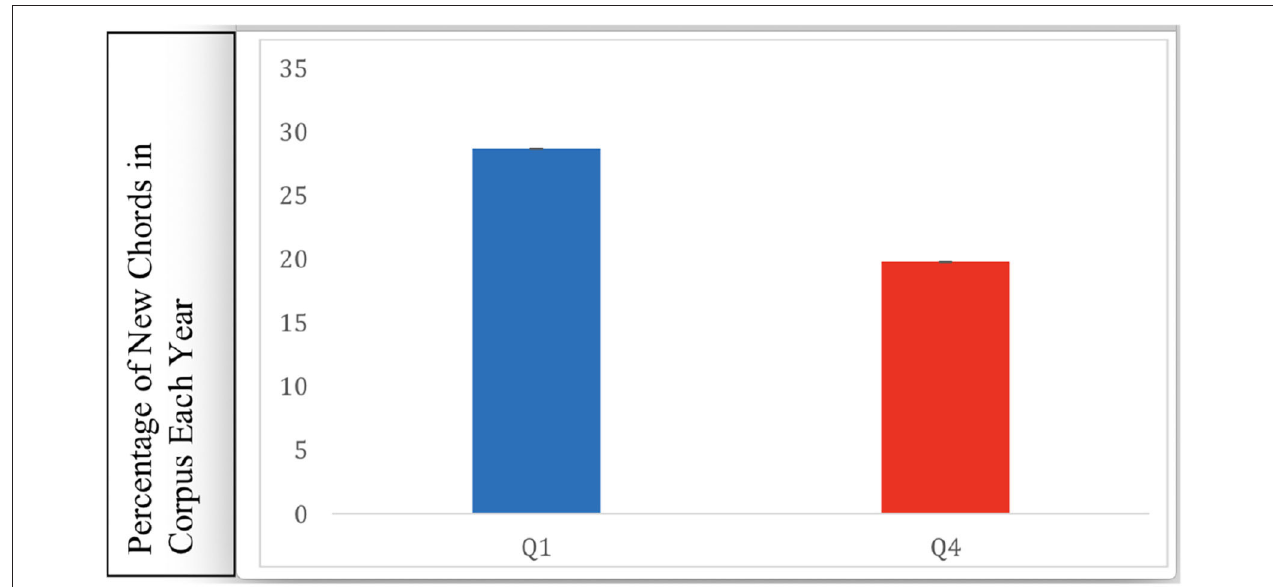
FIGURE 5 | Percentage of chords that appear over the years from 1959 to 1991, that had not appeared in songs of previous years, in Q 1 and Q 4 . Error bars represent standard error. There were significantly more novel chords featured in Q 1 songs.